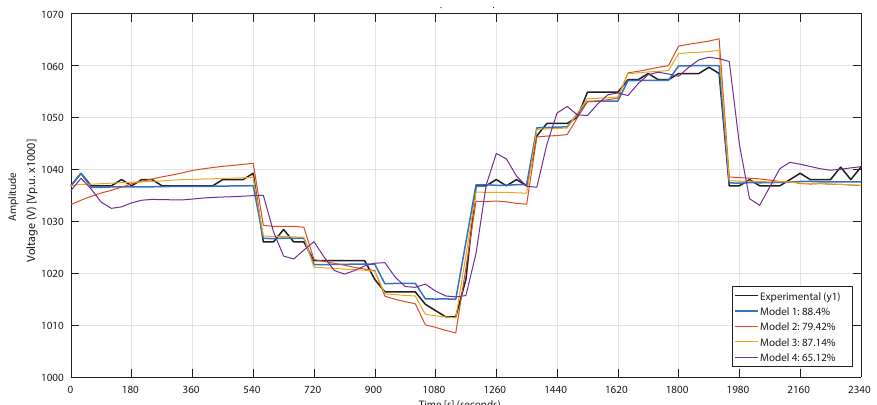
Figure 6. Experimental and model voltage response on B11_ADM PV system for the valida- tion